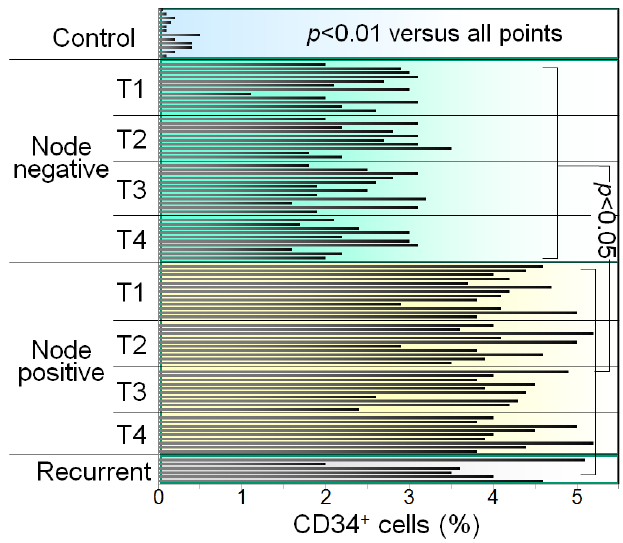
Figure 3. Levels of CD34 + cells are increased in the blood of HNSCC patients with nodal involvement compared to node-free